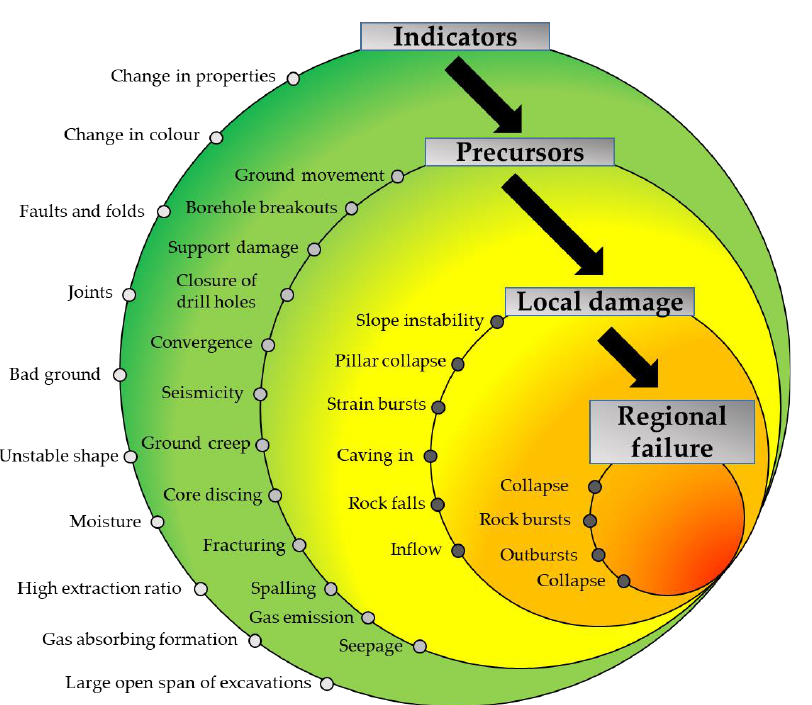
Figure 3. Indicators of the roof fall disintegration based on [33].